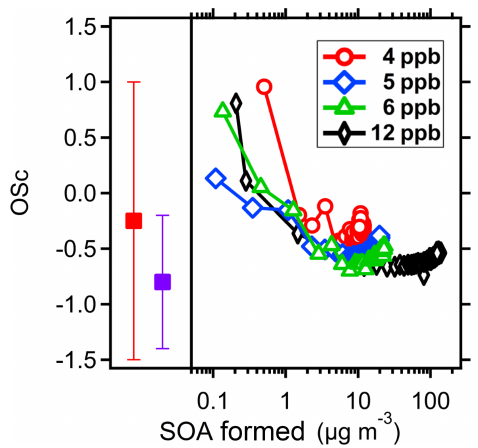
Figure 11. The OS C of the SOA from PD with initial concentrations at 4, 5, 6 and 12ppb on the right panel. The left panel shows the OS C of the oxidation products from PD in the clusters observed in the CLOUD experiments, which contained 1 (red solid square) and 4 (blue solid square) C 10 organics. The SOA formed at the very early stage (low yields) shows highly oxidized. The OS C in this study is comparable to the results from the CLOUD